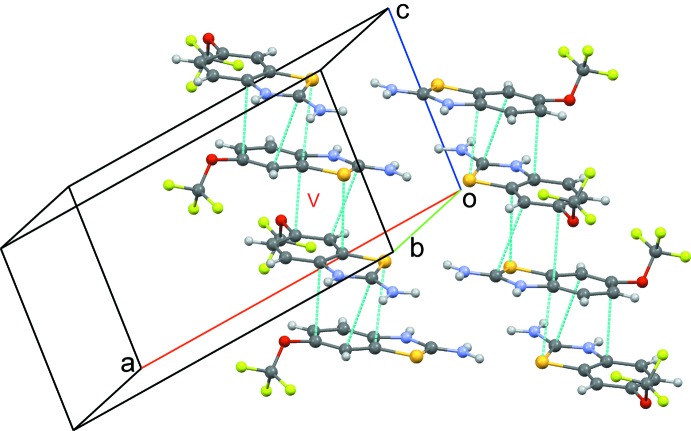
A comparative view of the packing of riluzolium chloride represented via C⋯C and C⋯S inter­molecular inter­actions. Dotted pale-blue lines depict the inter­molecular inter­actions.